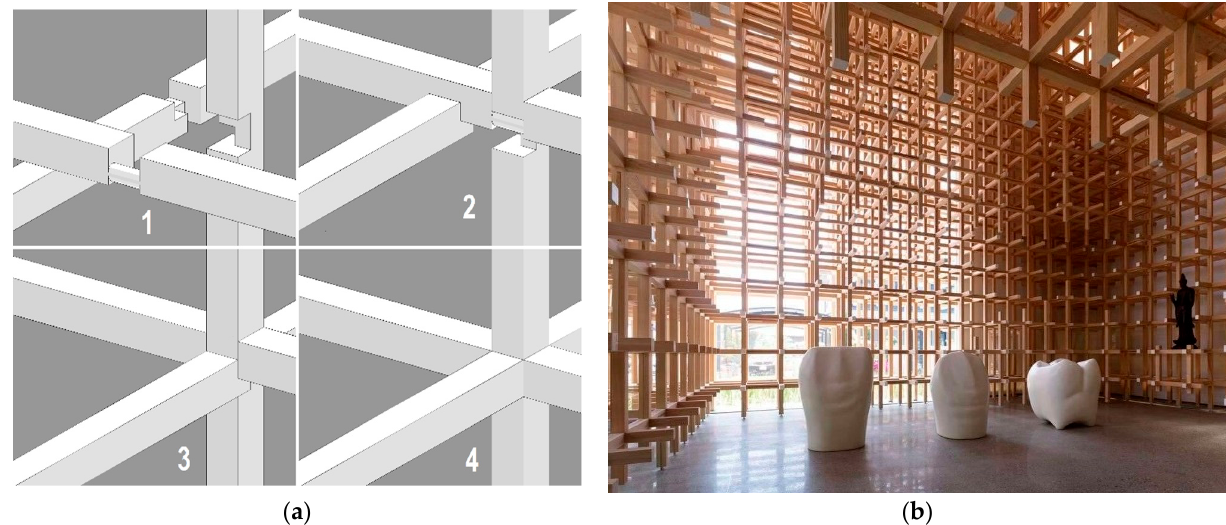
Figure 7. ( a ) The Chidori Joint GC Prostho Museum Research Center (2010), by Kengo Kuma; drawings: Piotr Arlet; ( b ) GC Prostho Museum Research Center ; interior, photo: Daici Ano; Source: https://www.archdaily.com/199442/gc-prostho-mu- seum-research-center-kengo-kuma-associates (accessed on 5 May 2021).